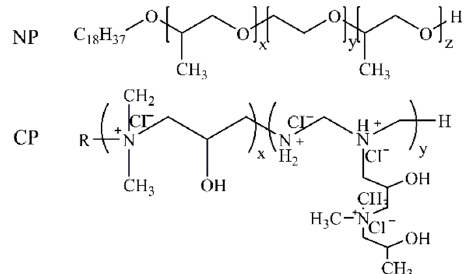
Figure 1. Basic structures of the cationic demulsifiers (CP) and nonionic ones (NP) (x, y and z are independent for different demulsifier, R represents the alkyl group).